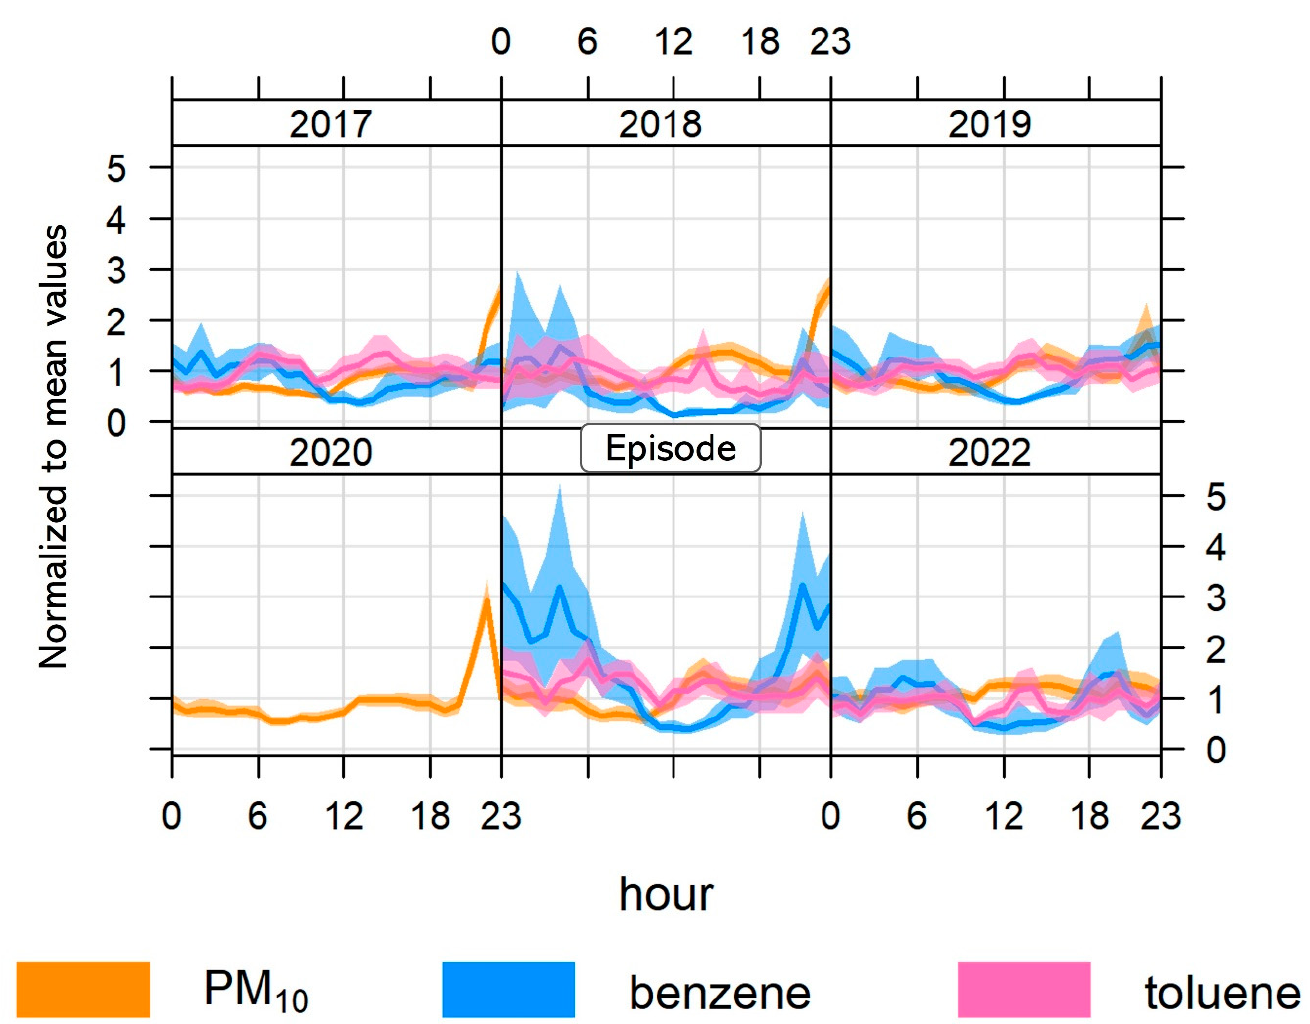
Figure 4. Normalized concentrations in relation to the mean value profiles for PM 10 , benzene, and toluene at Capuava AQS, from April to May for each year from 2017 to 2022. Episode represents the 2021 concentrations.